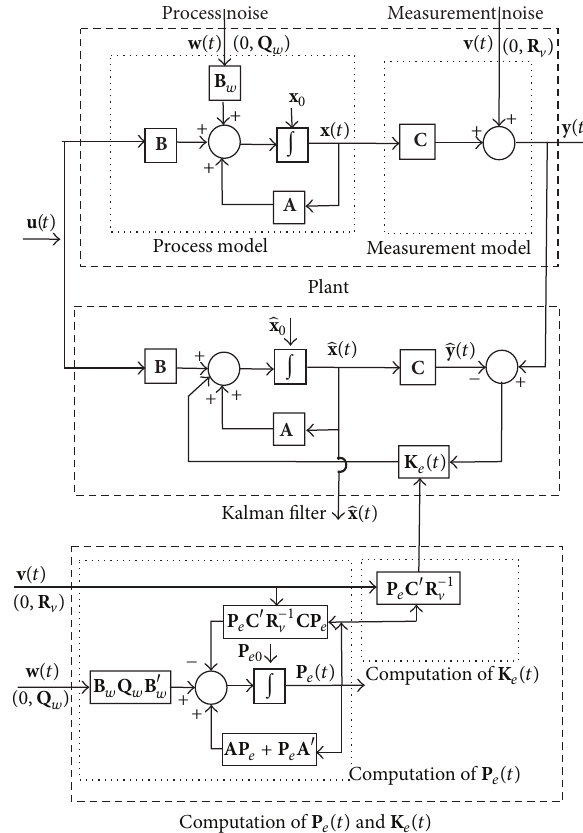
Figure 2: Standard linear continuous-time Kalman